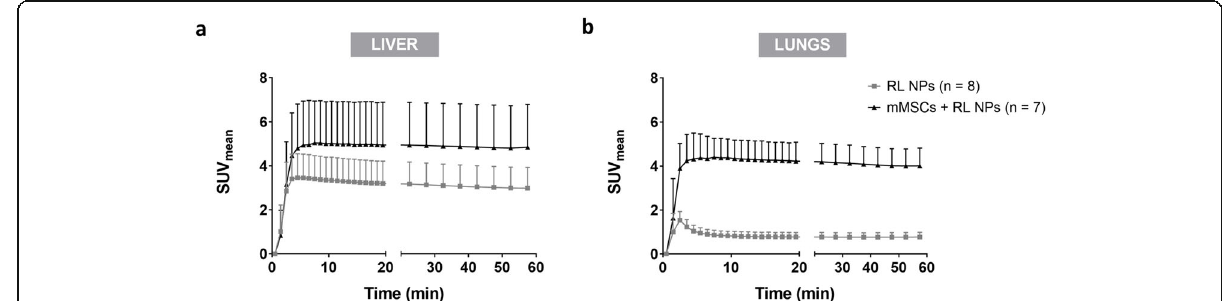
Fig. 3 Dynamic uptake pattern of 18 F-labeled-Fe 3 O 4 @Al(OH) 3 NPs or mMSCs labeled with these NPs. The static scans were reframed into 20 frames of 1 min and 8 frames of 5 min to study the uptake pattern of radiolabeled (RL) NPs and mMSCs over the time period of acquisition within a the liver and b the lungs. Uptake of RL NPs in the liver can be seen in both experimental groups as seen by the increase in mean standardized uptake value (SUV mean ), with a slow decreasing trend at later time points. On the other hand, the first pass of RL NPs in the lungs can be visualized, while there is stable uptake of mMSCs after 2 to 3 min